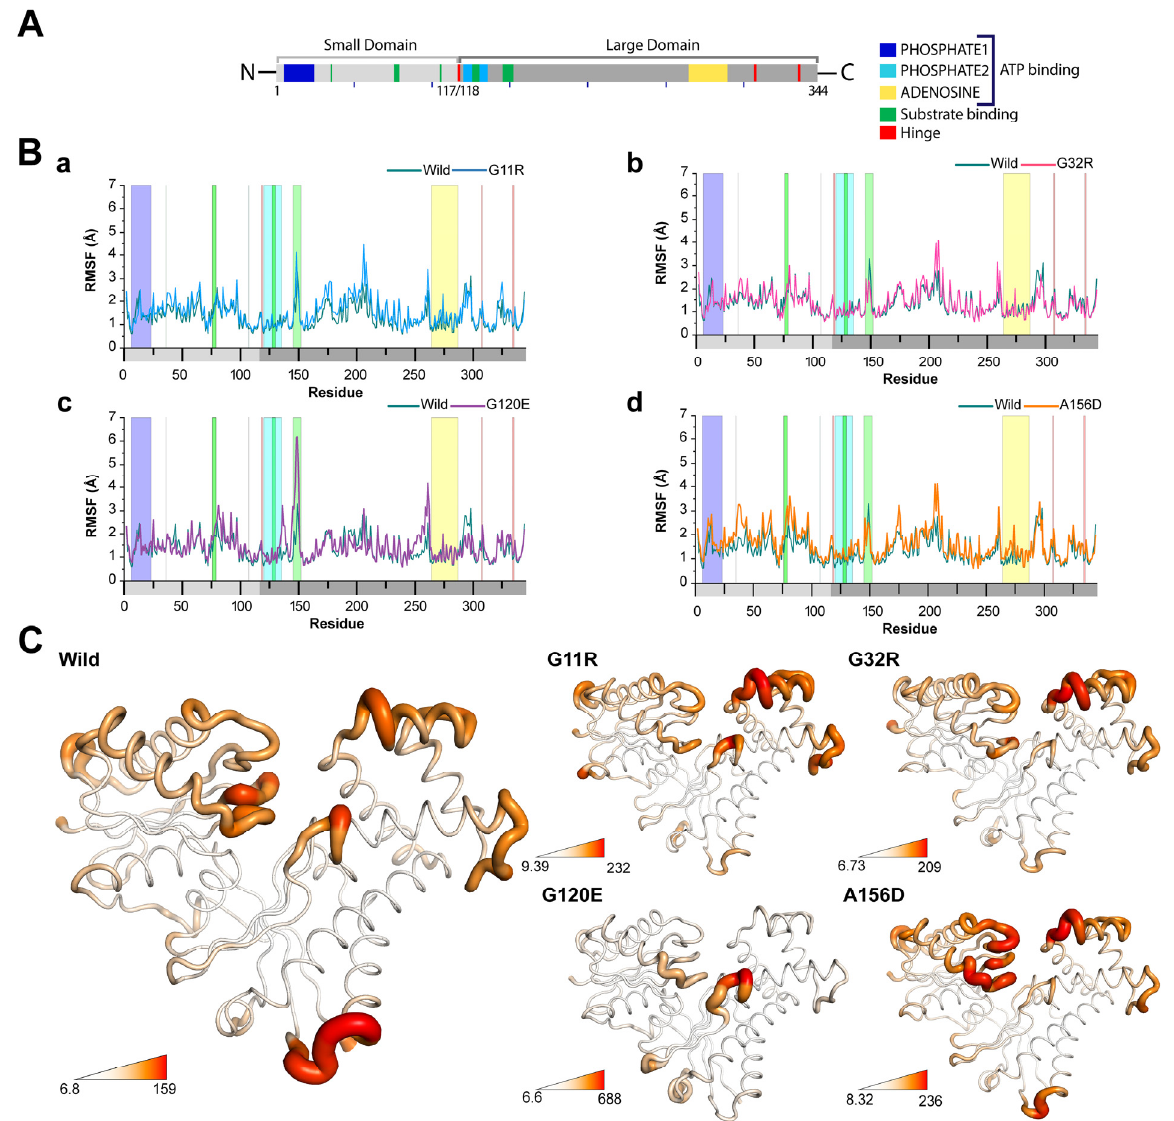
Figure 5. Alteration of residual flexibility in NAGK variants. ( A ) Map representing domains and motifs presents in NAGK involved in substrates and ATP binding. ( B ) The root mean square fluctuation (RMSF) plots highlighting the variations in structural flexibility between G11R ( a ), G32R ( b ), G120E ( c ), and A156D ( d ), compared to the wild-type. ( C ) The degree of flexibility is represented by the tube view of NAGK structure in various types with B-factor calculated from the RMSF analysis. The area having a high B-factor is shown as a broader tube with red shades, while a narrow tube with white shade means the regions have a low B-factor.